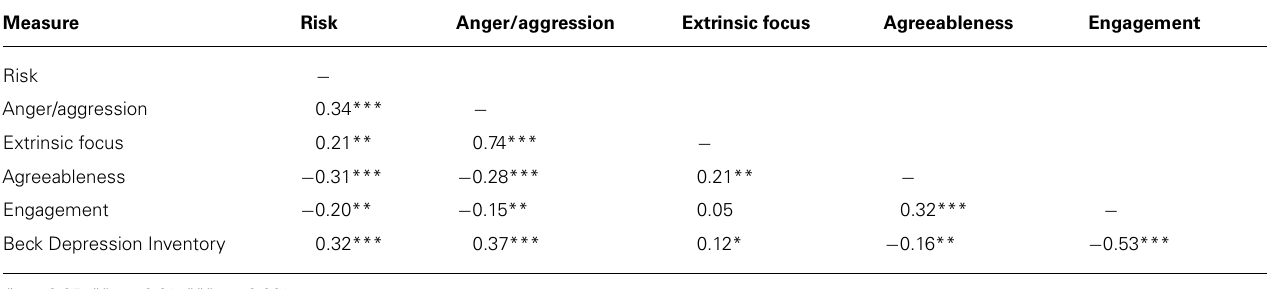
Table 3 | Correlation estimates between risky family scores, personality latent variables, and depression symptoms. Measure